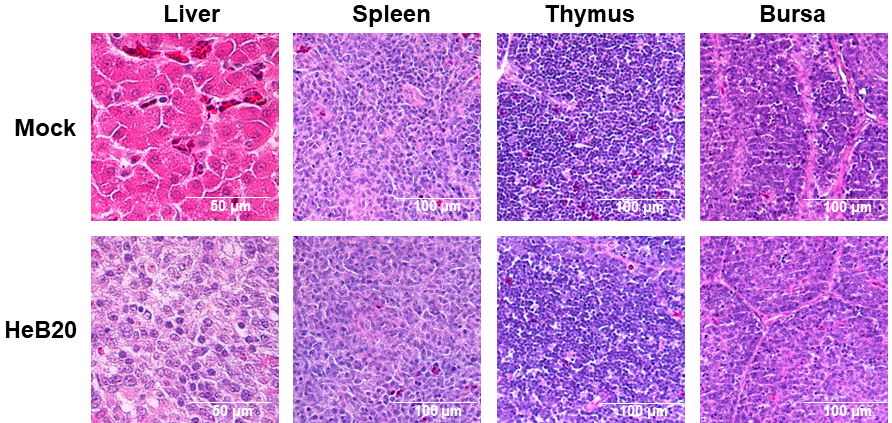
Figure 5. Histopathological analysis of chickens infected with HeB20. Degeneration and necrosis of hepatocytes and nuclear eosinophilic inclusion bodies showed in the liver. No significant histo- pathological changes were observed in immune organs (spleen, thymus, and bursa). Scale bar, 50 μ m.